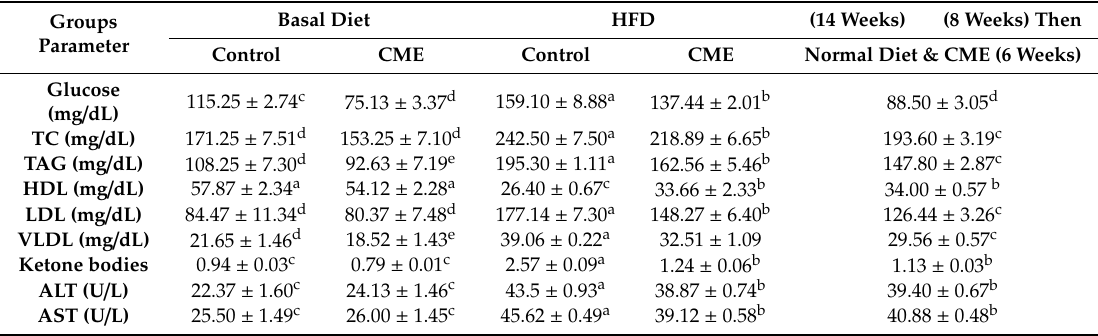
Table 5. E ff ect of HFD and / or Commiphora myrrha resin extract on blood glucose level, serum levels of lipid profile, ketone bodies and activities liver function biomarkers of rats after 14